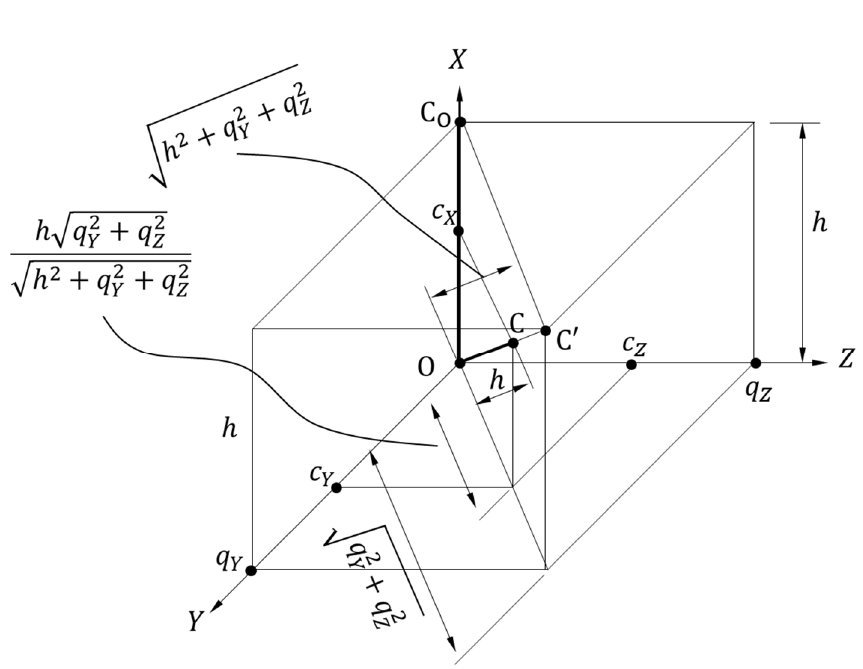
Figure 5. The geometric relationship by the displacements of the Y and Z actuators.